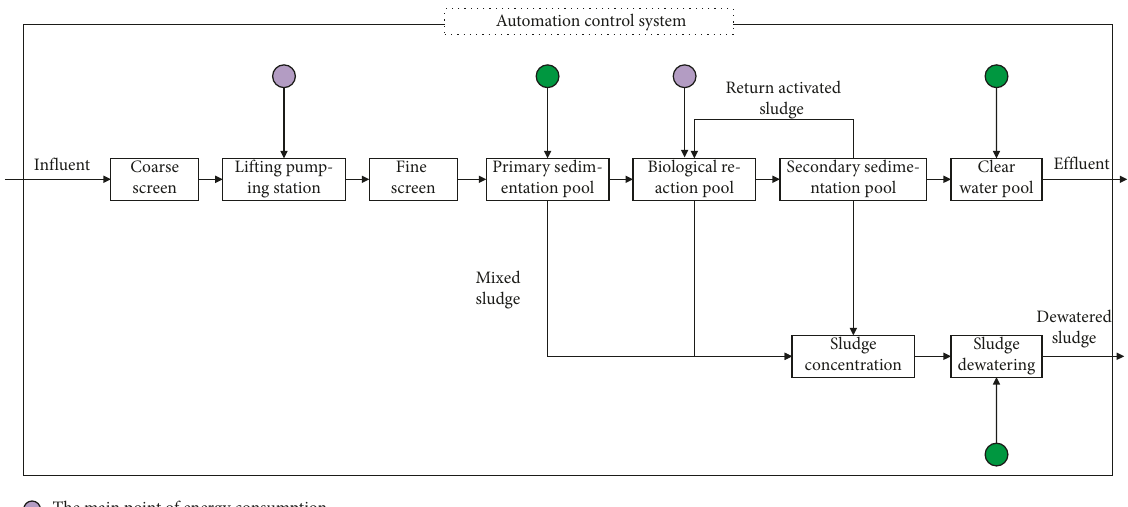
Figure 5: The process flow diagram of domestic wastewater